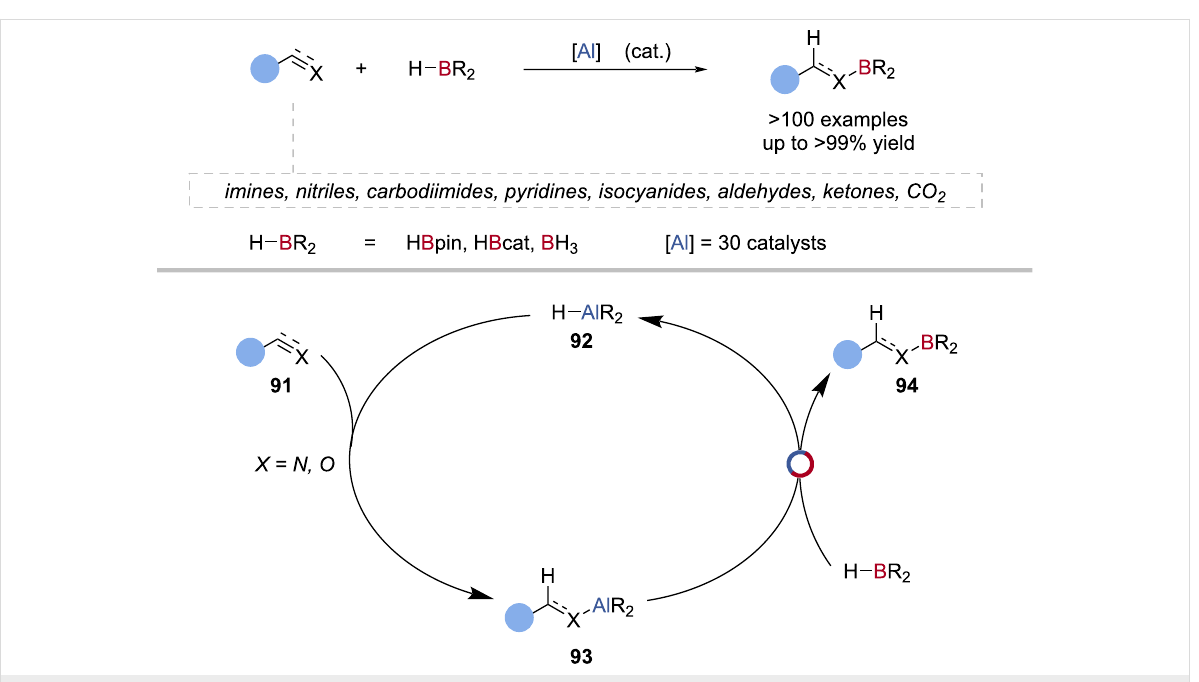
by Fontaine using tris(triphenylphosphine)aluminium as the catalyst and HBcat as the terminal reductant [110]. So et al. re- ported the bis(phosphoranyl)methanido aluminium hydride-cat- alysed reduction of CO 2 with Me 2 S·BH 3 as the terminal reduc- tant